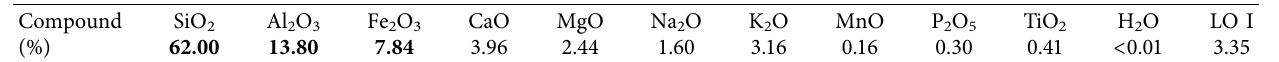
Table 9: Chemical compositions of CTCP.